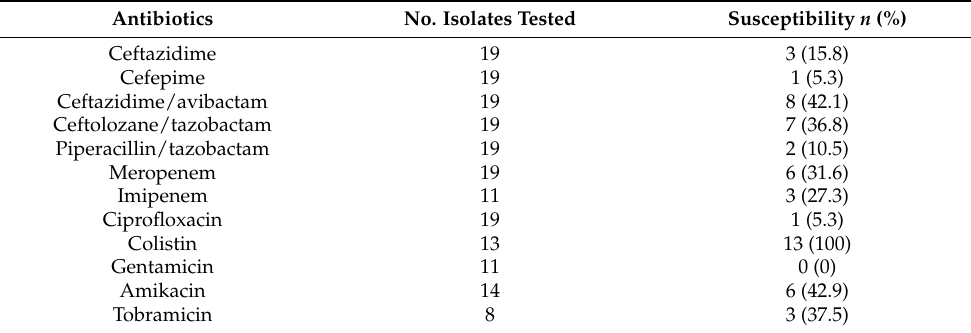
Table 2. Rates of antimicrobials’ susceptibility.